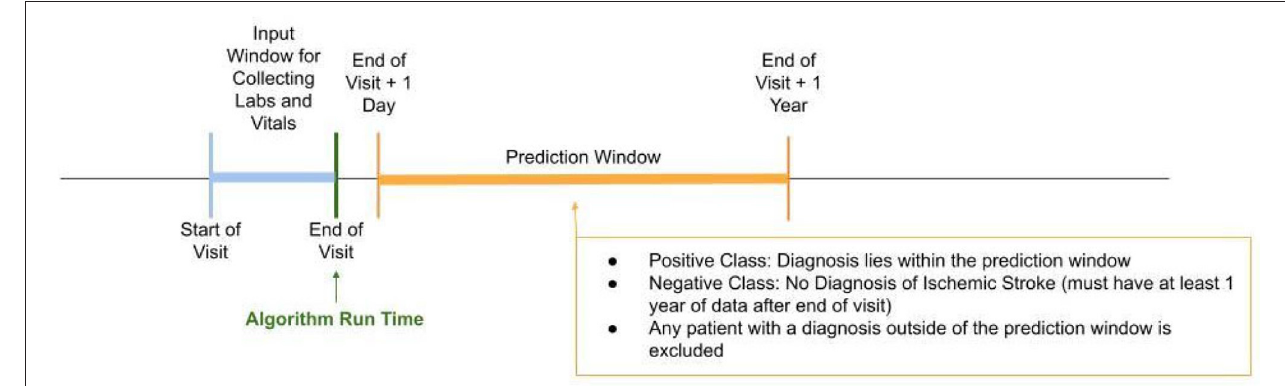
FIGURE 1 | Study design timeline. Patients identified in the positive class according to our gold standard had to have been diagnosed with ischemic stroke within the prediction window, i.e., 1 day after the end of visit to within 1 year from end of visit. The negative class included patients in which no diagnosis of ischemic stroke was identified within the prediction window and they must have had at least 1 year of data after the end of visit.